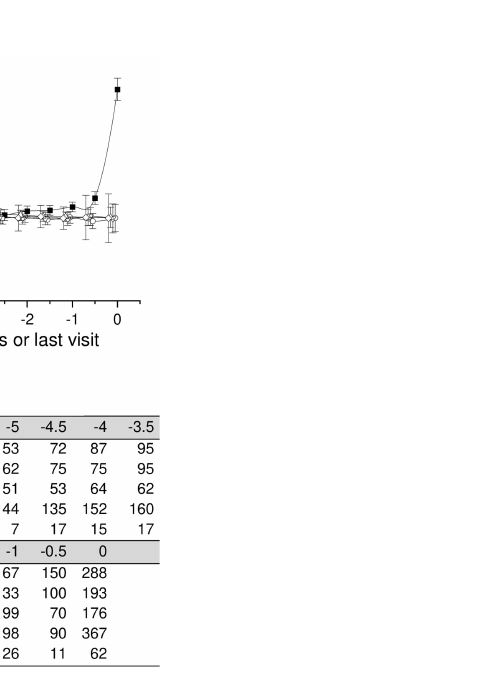
FIGURE 4 Adjusted mean random plasma glucose during the follow-up in children in fi ve risk groups. The last points are diagnosis of type 1 diabetes (progressors, black squares) or the last follow-up visit by August 31, 2014. Whiskers show 95% con fi dence intervals of the adjusted mean in the linear mixed model. No signi fi cant differences in the early random plasma glucose values were observed between the groups. Random plasma glucose values started to increase toward diagnosis in the progressors.